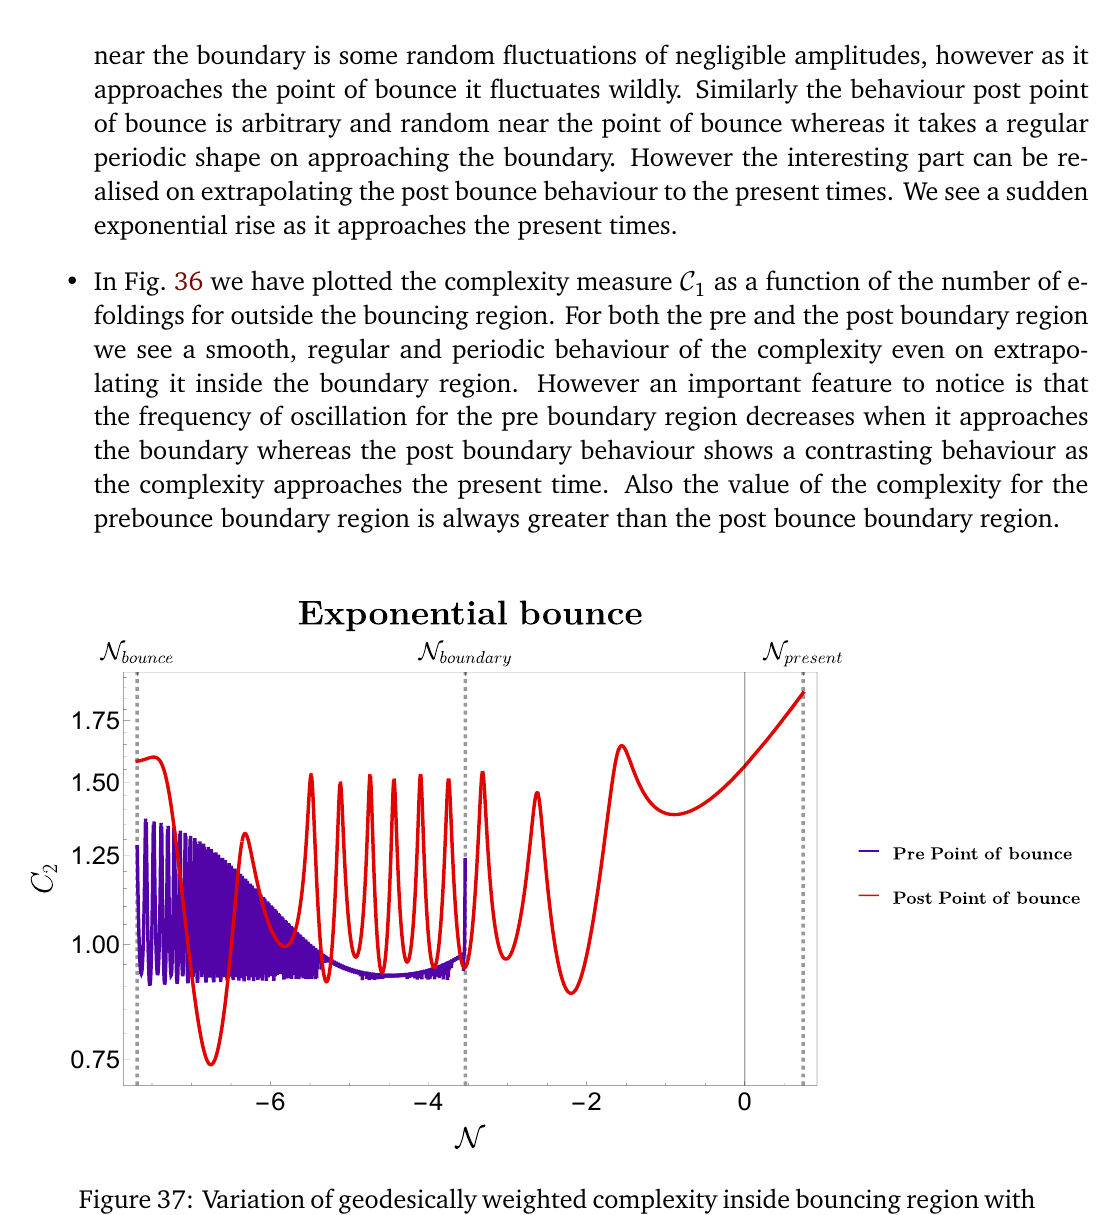
Figure 37: Variation of geodesically weighted complexity inside bouncing region with respect to number of